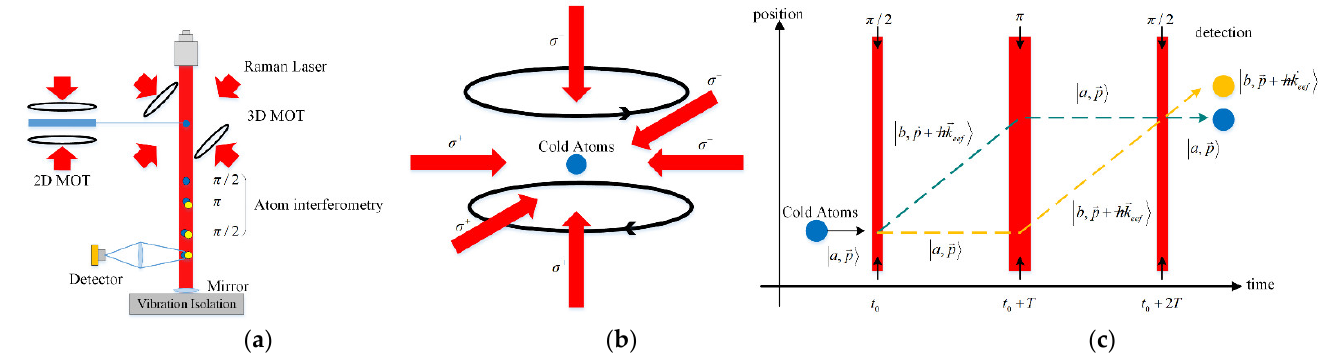
Figure 1. Principles of an AIG. ( a ) Operation diagram of an AIG; ( b ) Diagram of three-dimensional MOT atom cooling and trapping; ( c ) Diagram of Raman pulse atomic interference. Three Raman light pulse beams cause the beam splitting, reflection and combination of atomic wave packet to result in interference.